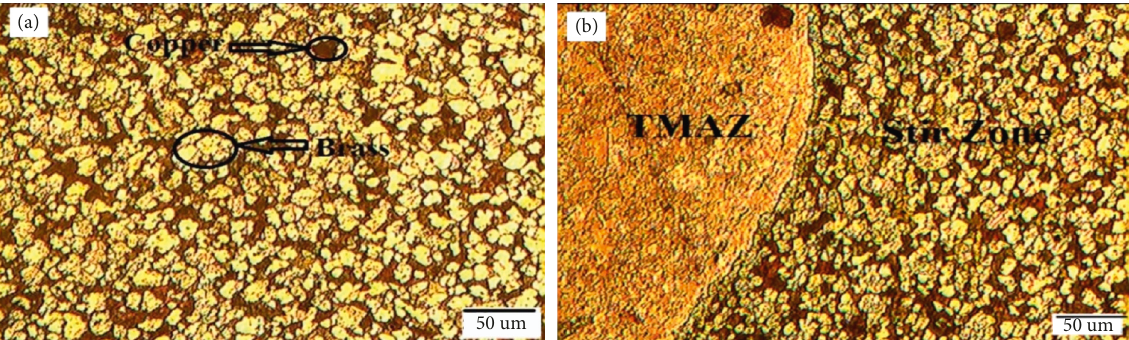
Figure 3: OM image at the rotational speed of 1000rpm (a) Stir zone (b) TMAZ.